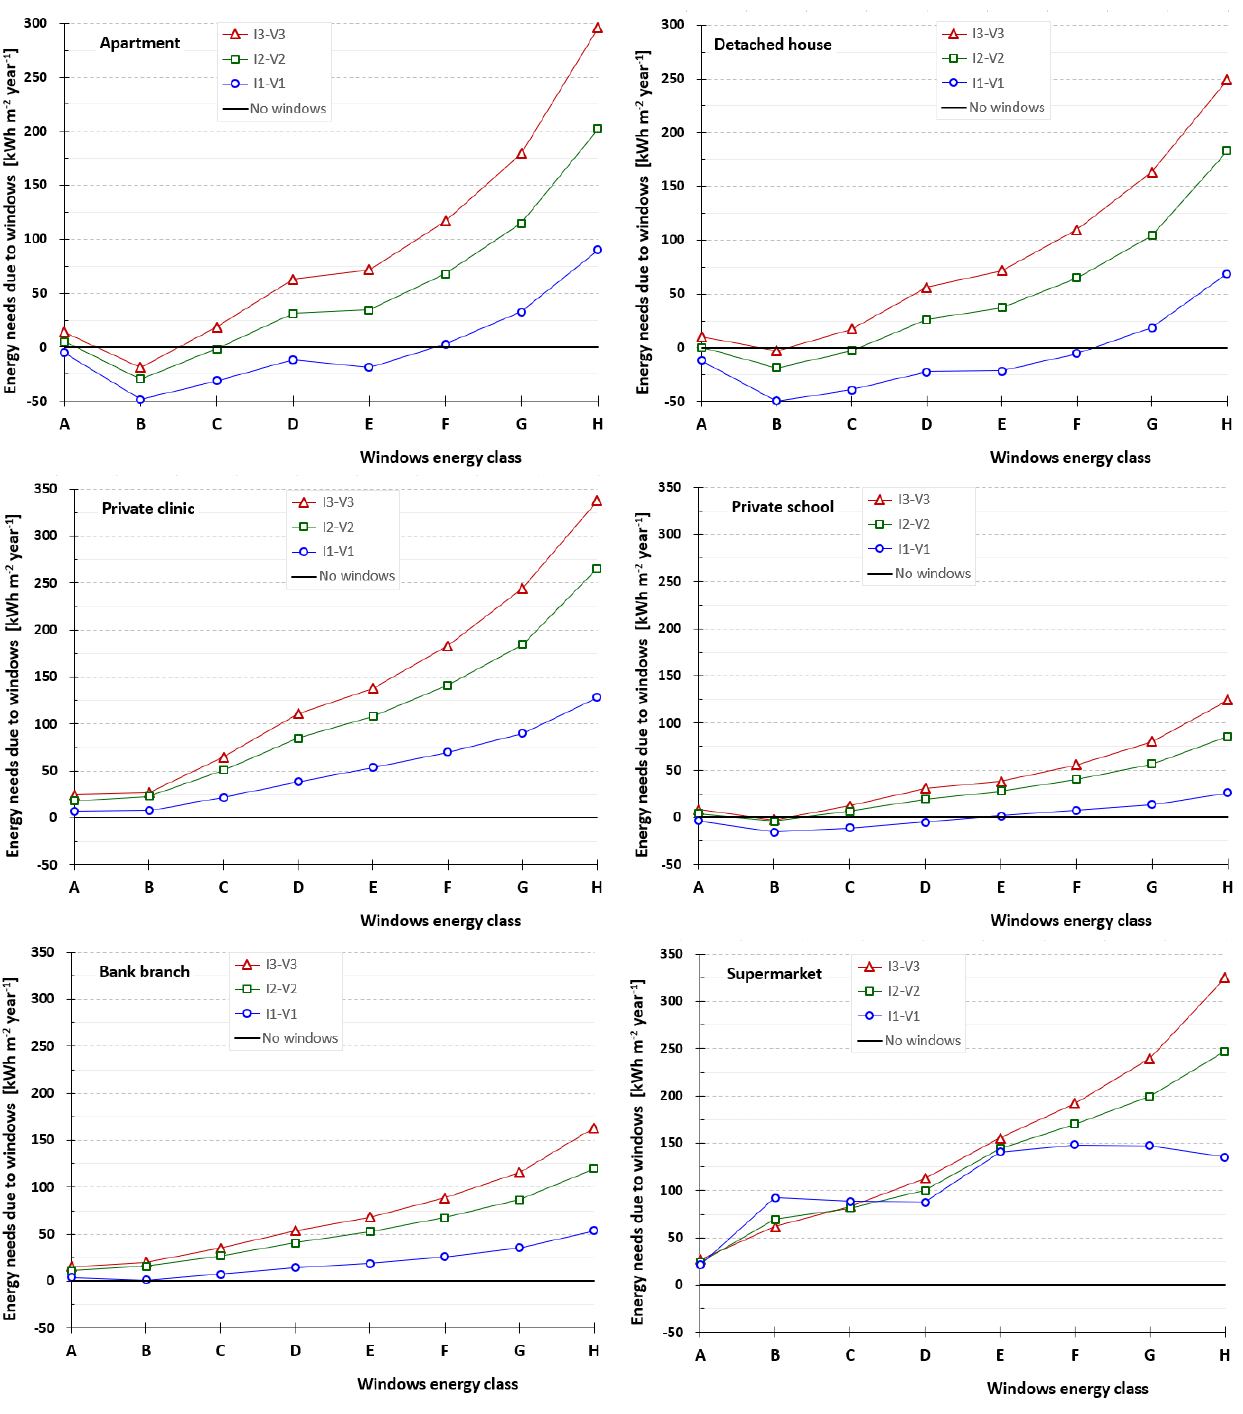
Figure 1. Energy needs for air-conditioning due to windows for each building type, varying according to each climate zone (values per m 2 of glazed area of external envelope).